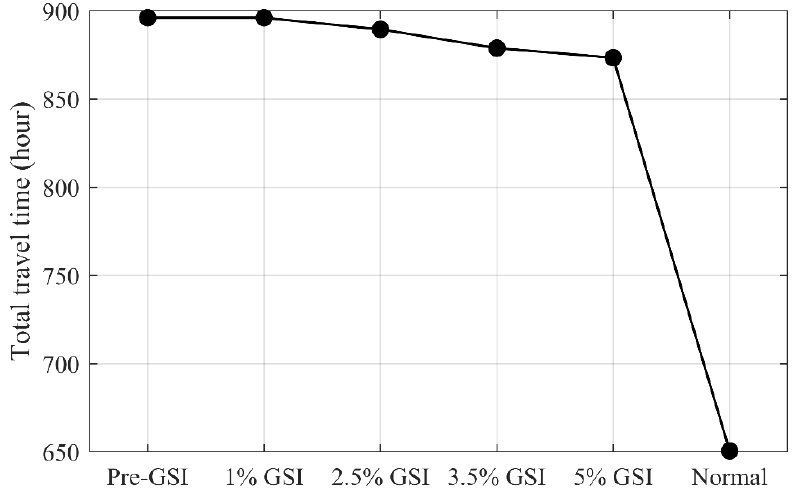
Figure 11. Total travel time (h, y-axis) of all vehicle trips in the normal, pre-GSI, and GSI scenarios (x-axis).